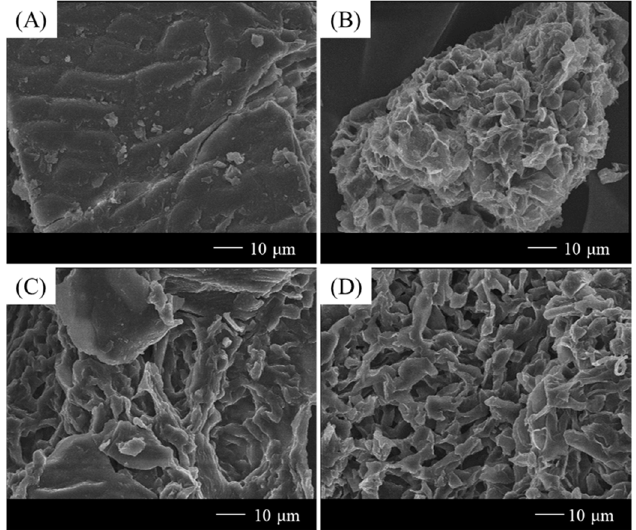
Figure 2. Configuration of PUL surface after extraction using different solvents. ( A ) PUL surface before extraction; ( B ) PUL surface after extraction with water; ( C ) PUL surface after extraction with DES synthesized using CC and malonic acid; ( D ) PUL surface after extraction with DES synthesized using CC and GA.